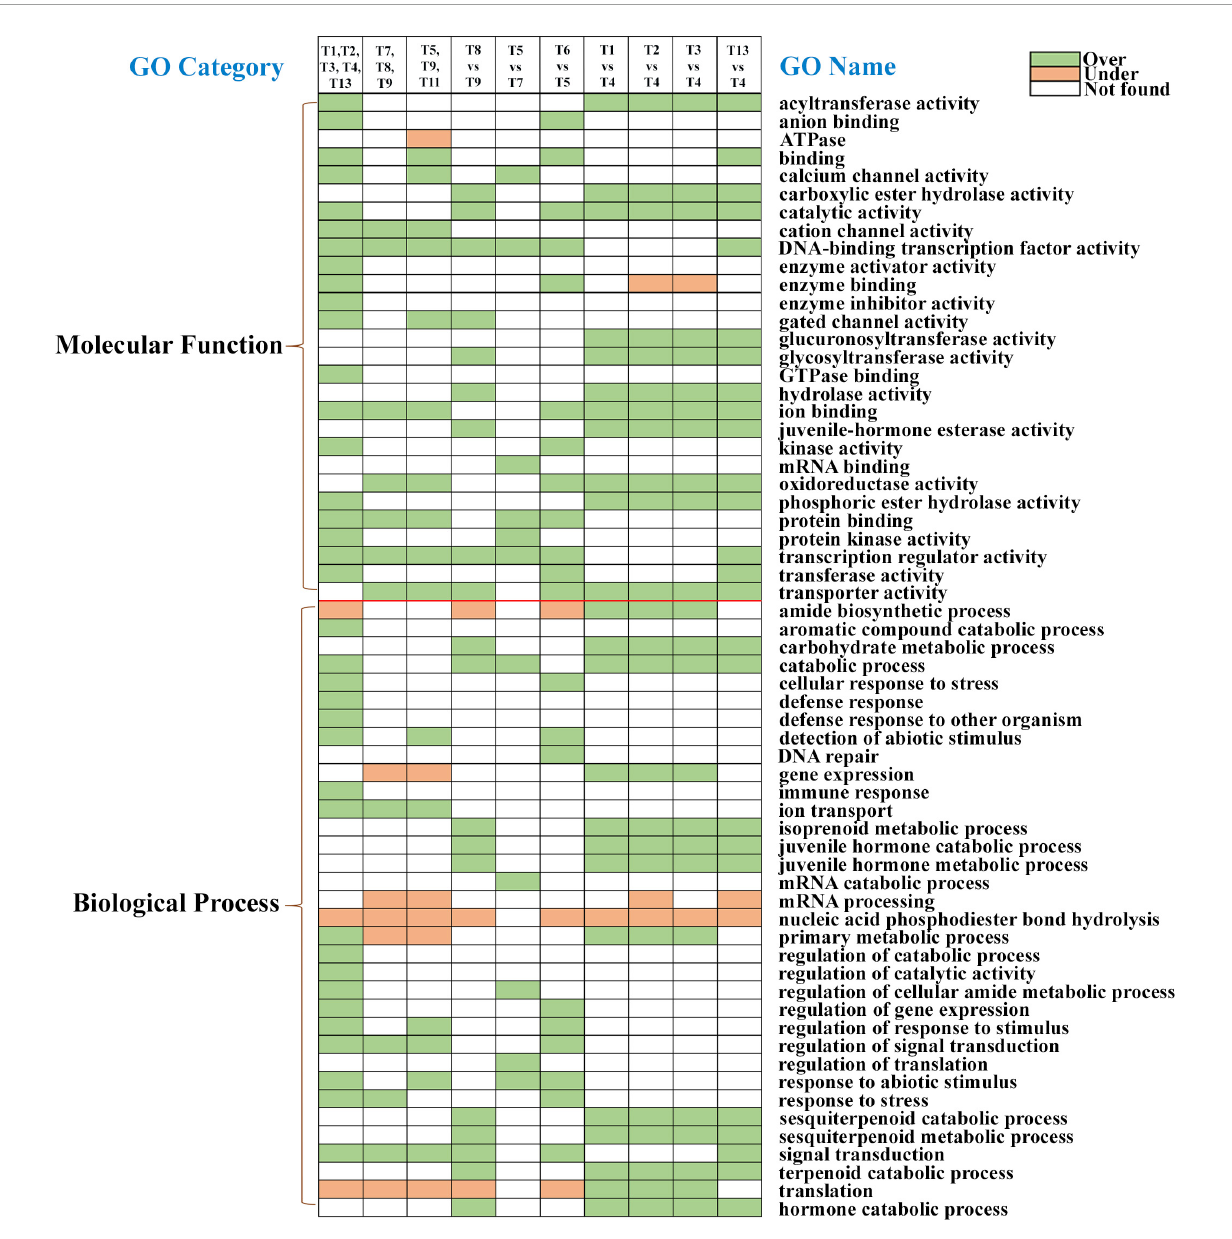
FIGURE10 Critical physiological processes in different ESBB sample comparisons after GO enrichment analysis (FDR p < 0.05, fold change ≥ 2). Green boxes are over-enriched, orange boxes are under-enriched, and white boxes represent processes not occurring in a particular